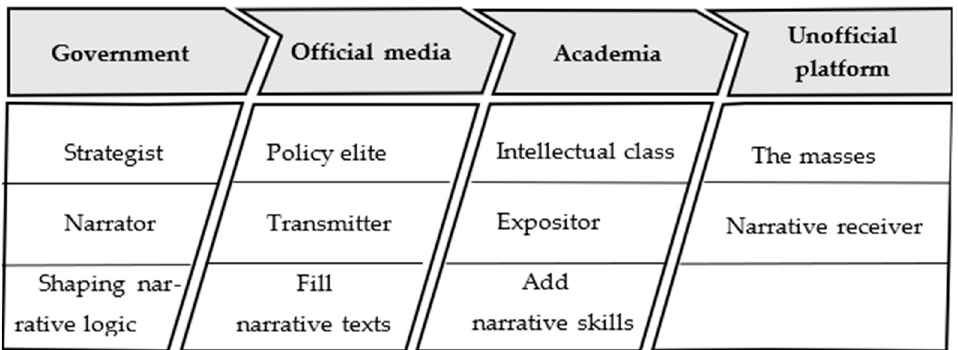
Figure 1. Production process of strategic narratives.